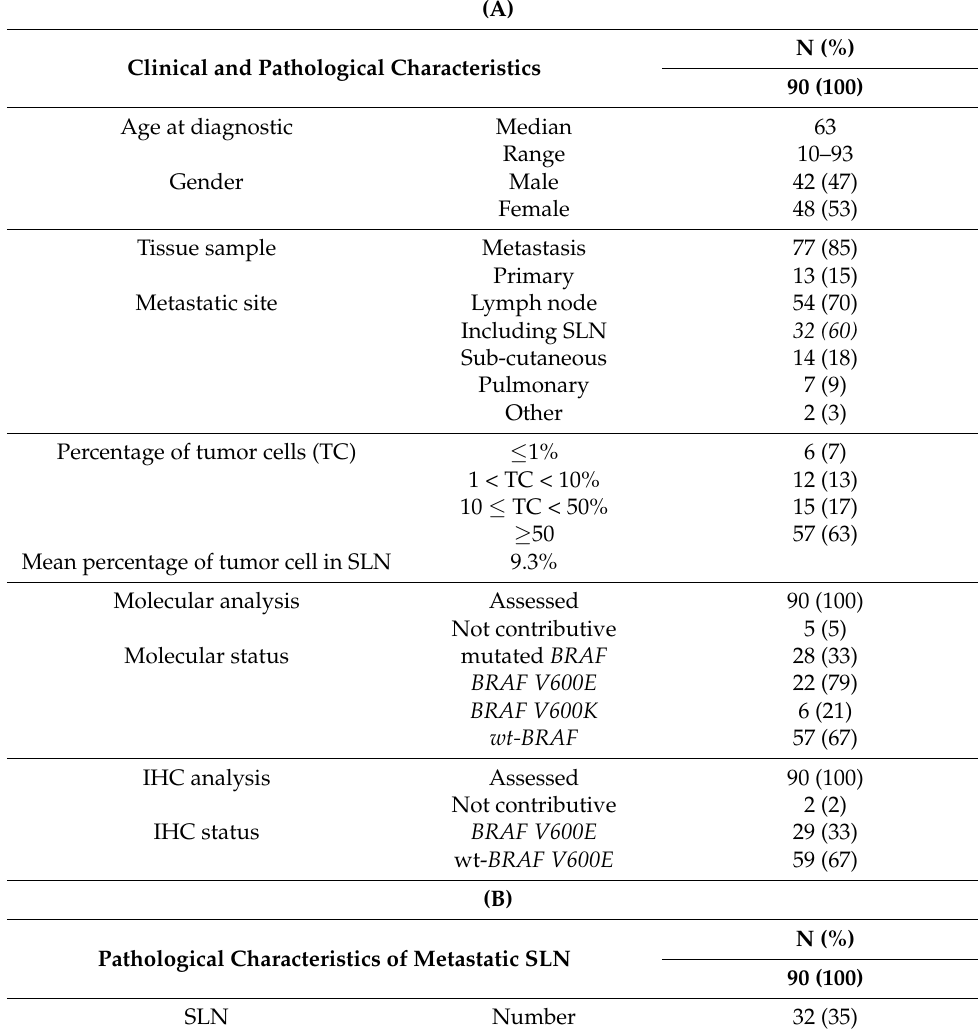
Table 2. (A) Clinical and pathological characteristics of the 90 melanoma patients included in the study. (B) Focus on the metastatic SLN